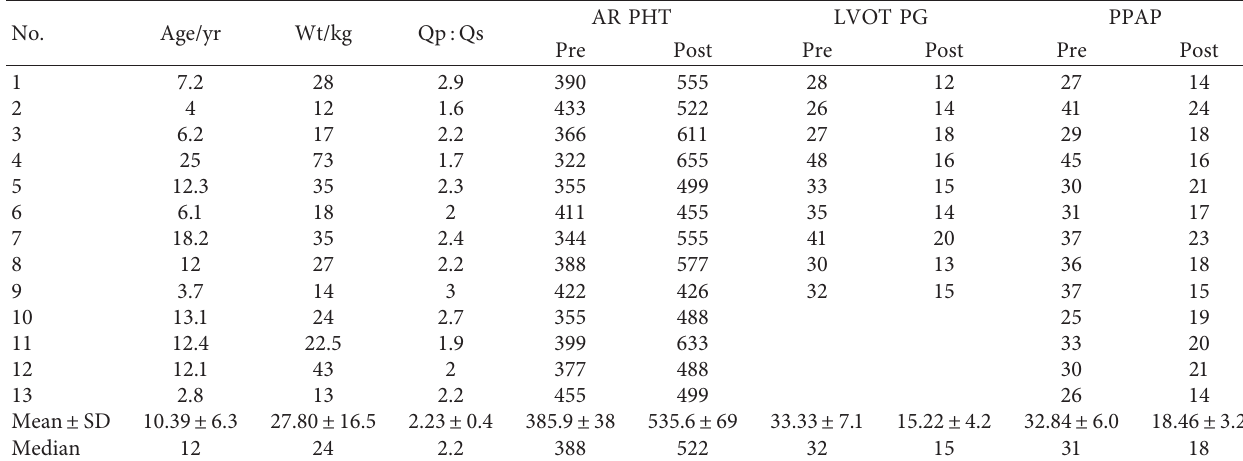
Figure 5: (a) Left ventriculogram in the left anterior oblique (70 ° ) and cranial (20 ° ) projection of a 2.5-year-old female patient demonstrates a small subaortic VSD. (b) Aortogram in the left anterior oblique (60 ° ) projection reveals mild AR. (c) Left ventriculogram in the left anterior oblique (70 ° ) and cranial (20 ° ) projection documents excellent device deployment with no residual shunt. (d) Aortogram in the lateral (90 ° ) and cranial (20 ° ) projection demonstrating proper device positioning with no AR. Table 1: Hemodynamic characteristics of patients with LVOT obstruction and